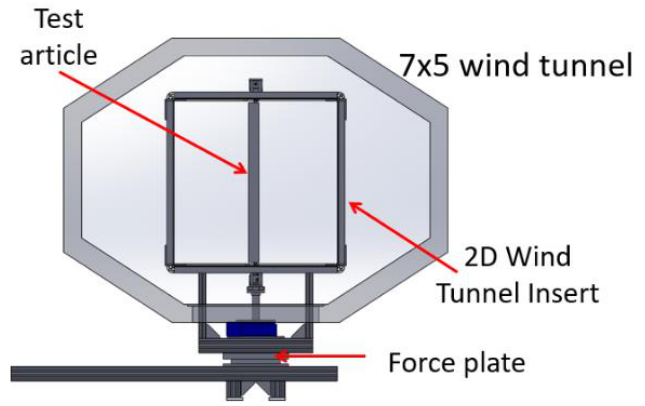
Figure 14. 2D wind tunnel insert inside 7-ft × 5-ft test section.